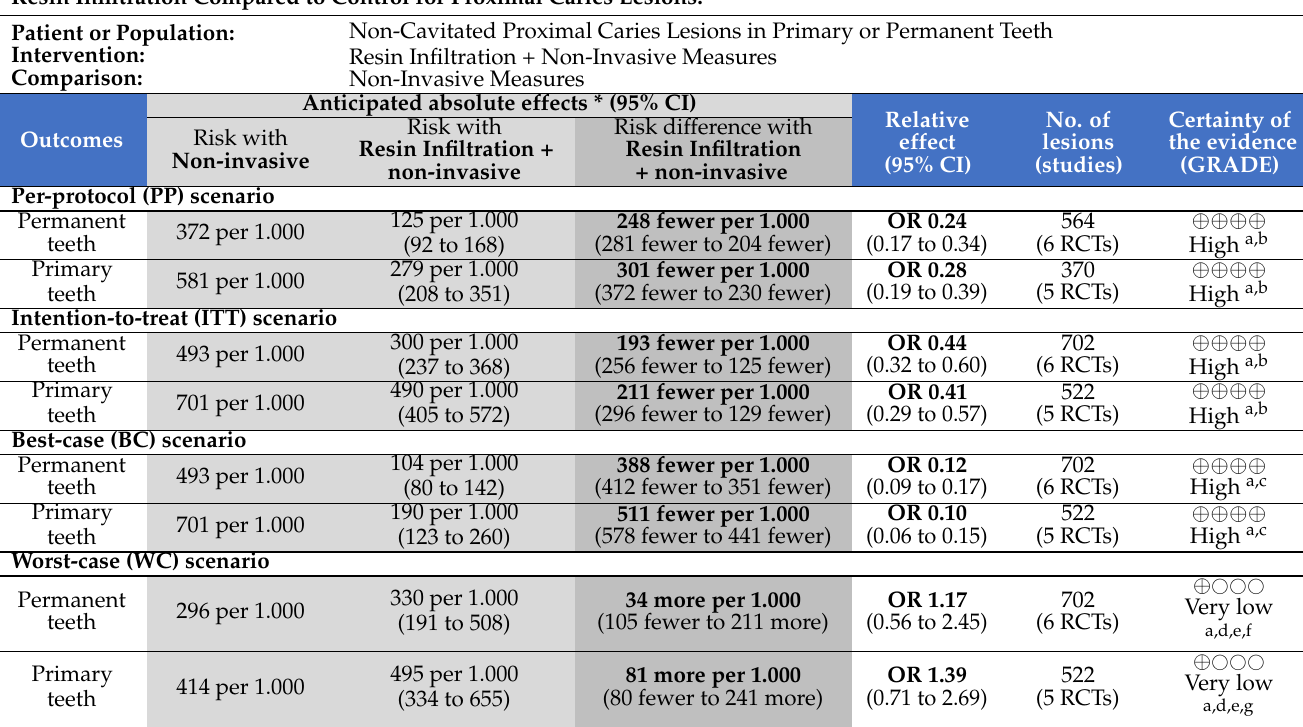
Table 1. Summary of findings table according to GRADE. Evidence supporting resin infiltration and non-invasive measures versus non-invasive measures alone in preventing lesion progression in permanent and primary teeth has been assessed. The risk of lesion progression in the test group and the control group, the relative effects based on the number of studies, and assessed lesions are given. Resin Infiltration Compared to Control for Proximal Caries